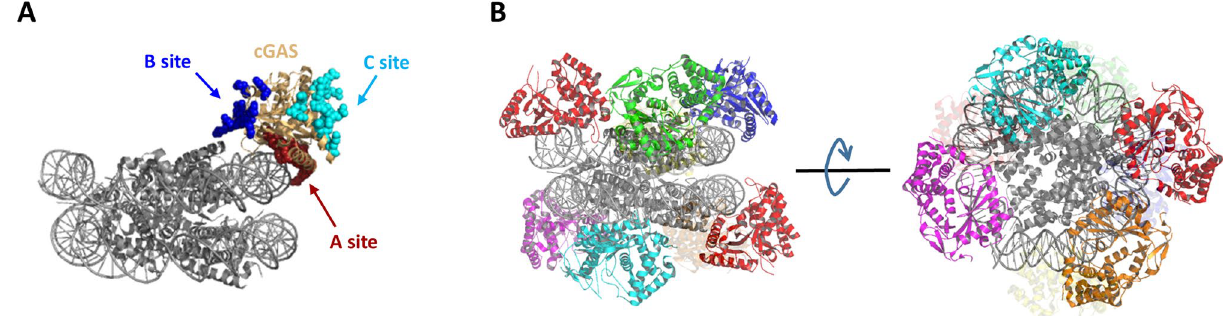
Figure 6. Modelling of the complex formed by binding of cGAS to the 145-nucleosome. ( A ) cGAS binds nucleosomal DNA using the “A site”. ( B ) Multiple cGAS molecules bind to one nucleosome to form a cGAS n - nucleosome 1 complex. The cGAS n -nucleosome 1 model was obtained by docking 145-nucleosome (PDB code: 3LZ0) onto the major dsDNA binding region (“A site”) of cGAS based on the crystal structure of the cGAS 1 - dsDNA 1 complex (PDB code: